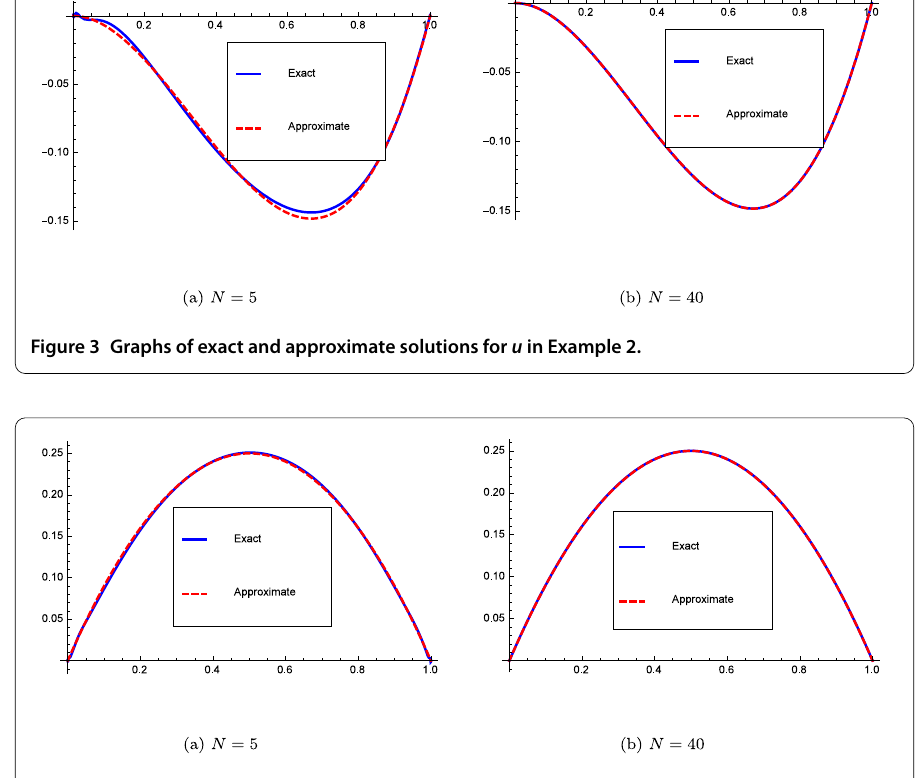
Figure 4 Graphs of exact and approximate solutions for v in Example